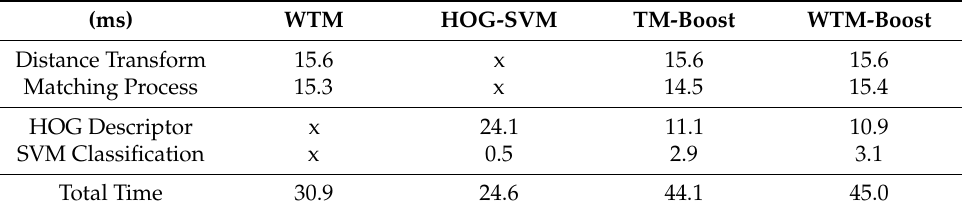
Figure 6. The 40 learned weak classifiers for TM-Boost and WTM-Boost methods, respectively. Table 1. Processing time analysis for a testing sample (64 × 128).